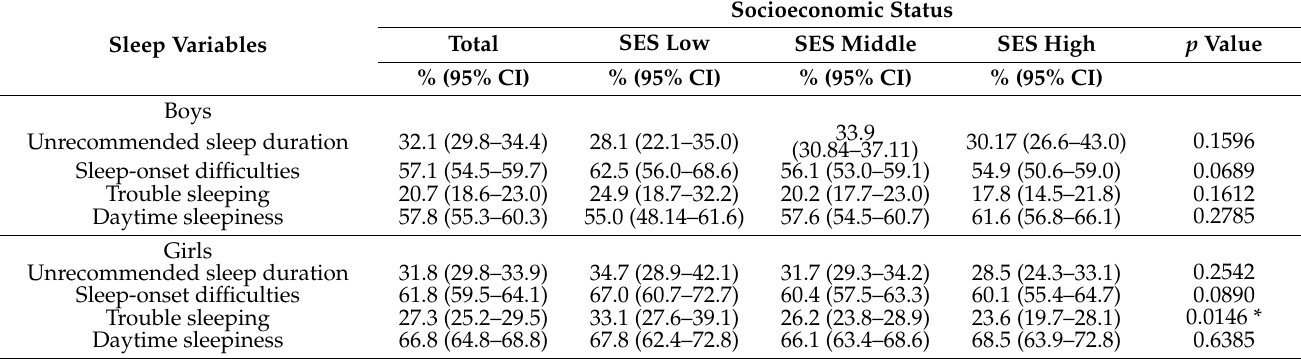
Table A1. Sleep difficulties in adolescents stratified by socioeconomic status.